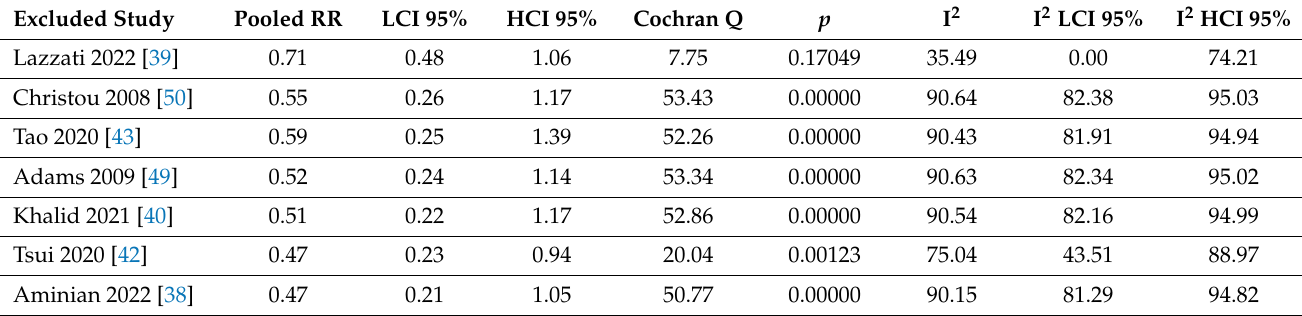
Figure A18. Thyroid cancer random e ff ects model funnel plot.